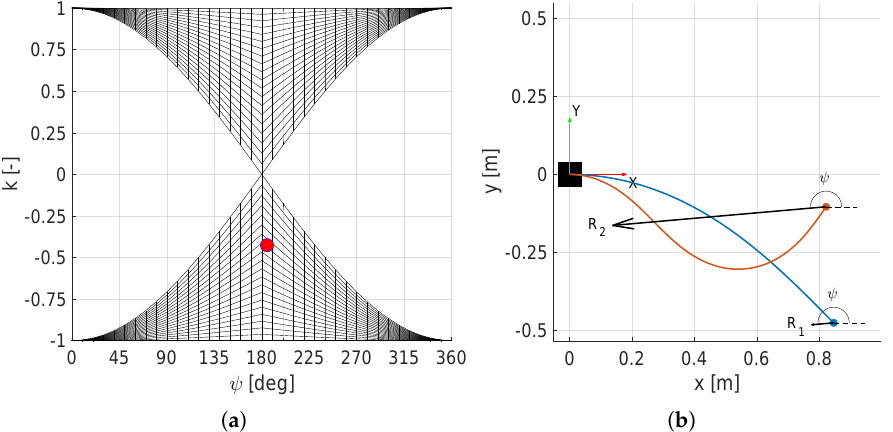
Figure 3. ( a ) Given values of k and ψ . ( b ) Deformed shapes for buckling modes 1 and 2 of a clamped-hinged rod.